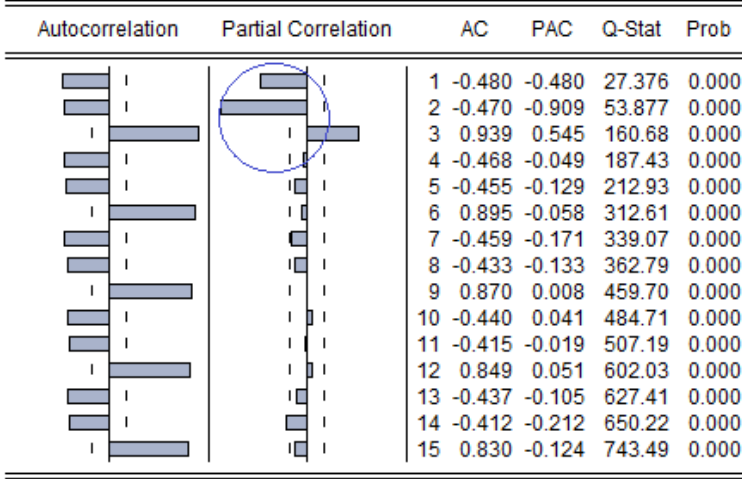
Figure 5 . The ACF and PACF of electricity load sequences for the small sample. Figure 5. The ACF and PACF of electricity load sequences for the small sample. Energies 2019 , 11 , x FOR PEER REVIEW